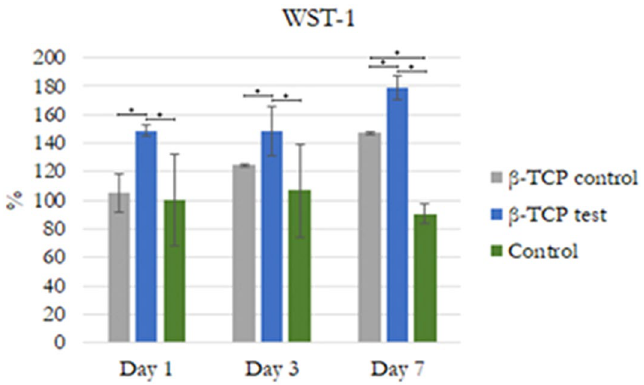
Figure 6. Cell proliferation. WST-1 on days 1, 3, and 7. Statistically significant differences are indicated by * P < 0.05.